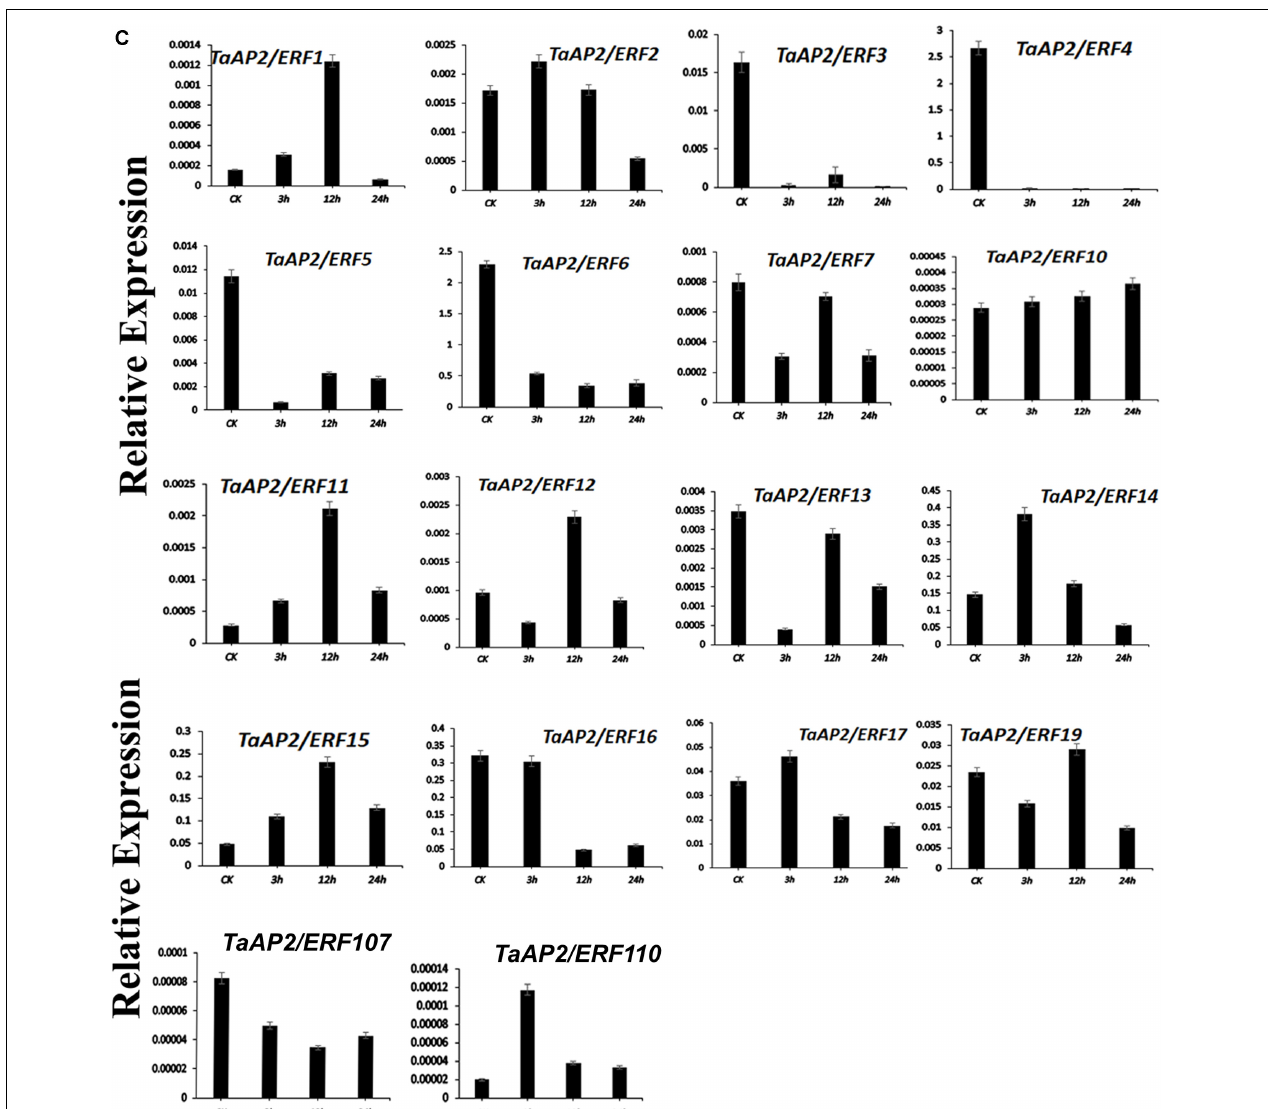
FIGURE 7 | The relative expression level of TaAP2/ERF genes under different Stresses (A) Under Heat Stress (B) Under NaCl Stress (C) Under Drought Stress. Error bars indicate the standard error (SE) between three